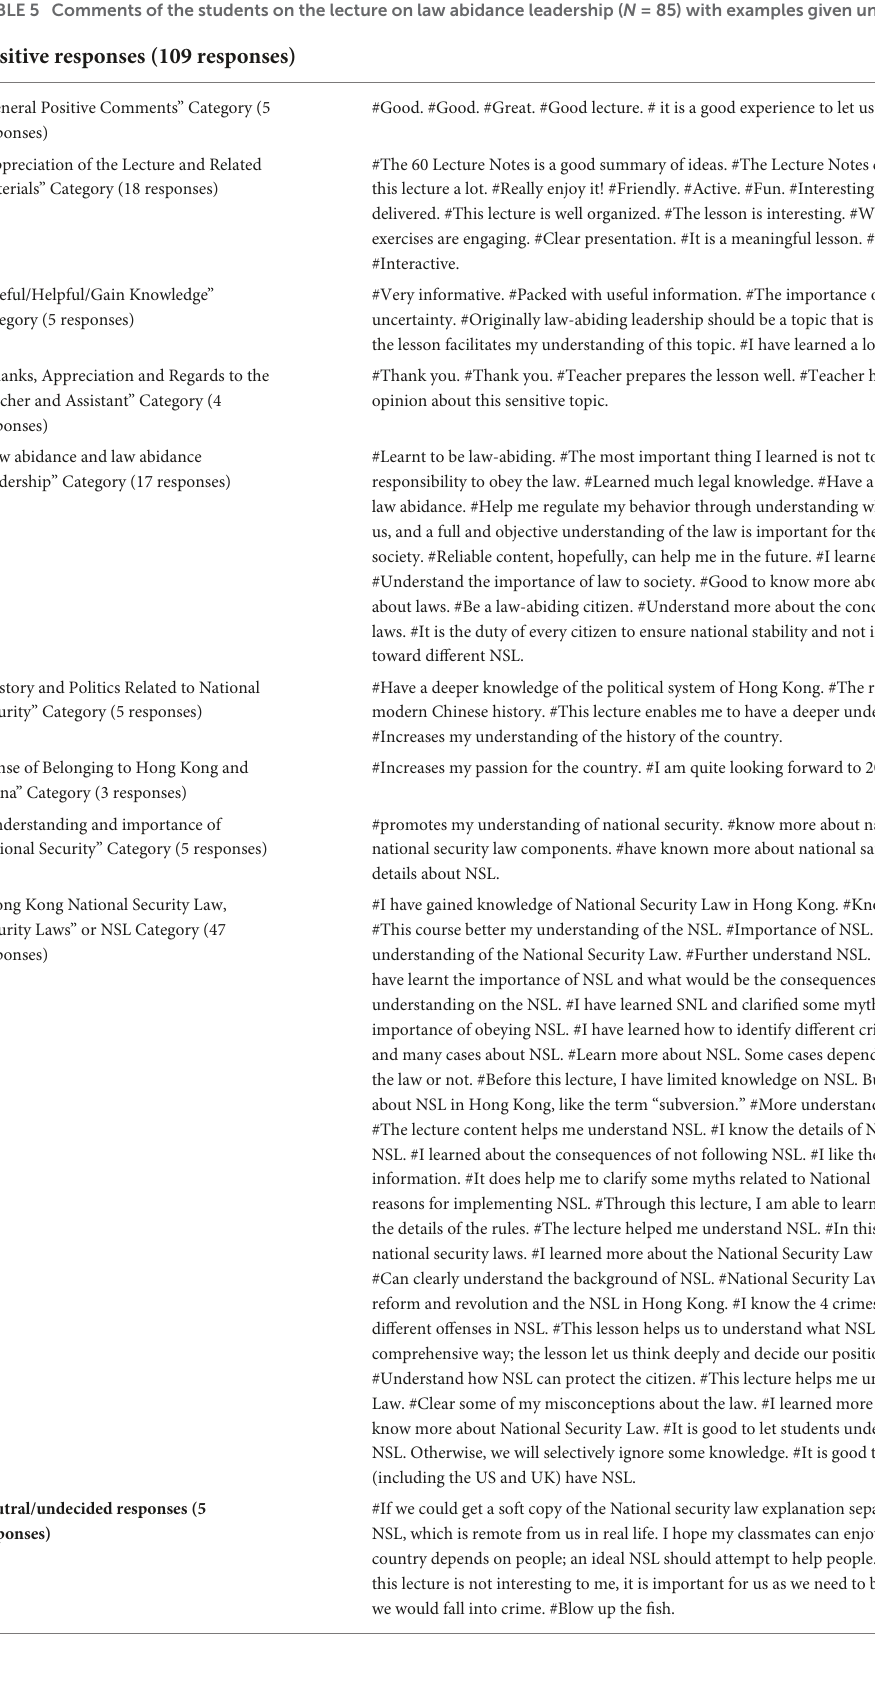
TABLE 5 Comments of the students on the lecture on law abidance leadership ( N = 85) with examples given under each category or